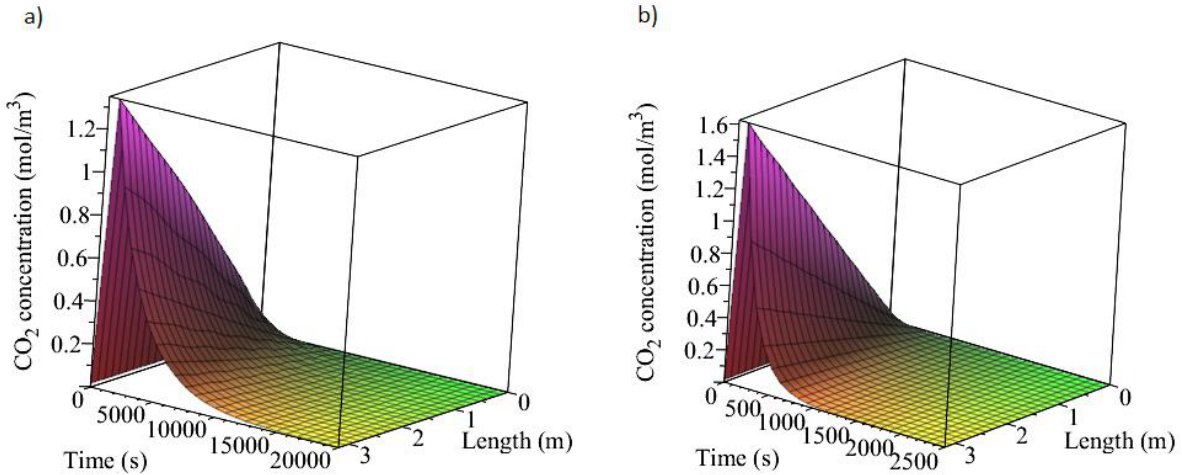
Figure 8. CO 2 concentration during the desorption step for chemisorbents: ( a ) SI-AEATPMS sorbent and ( b ) APDES-NFC-FD sorbent .